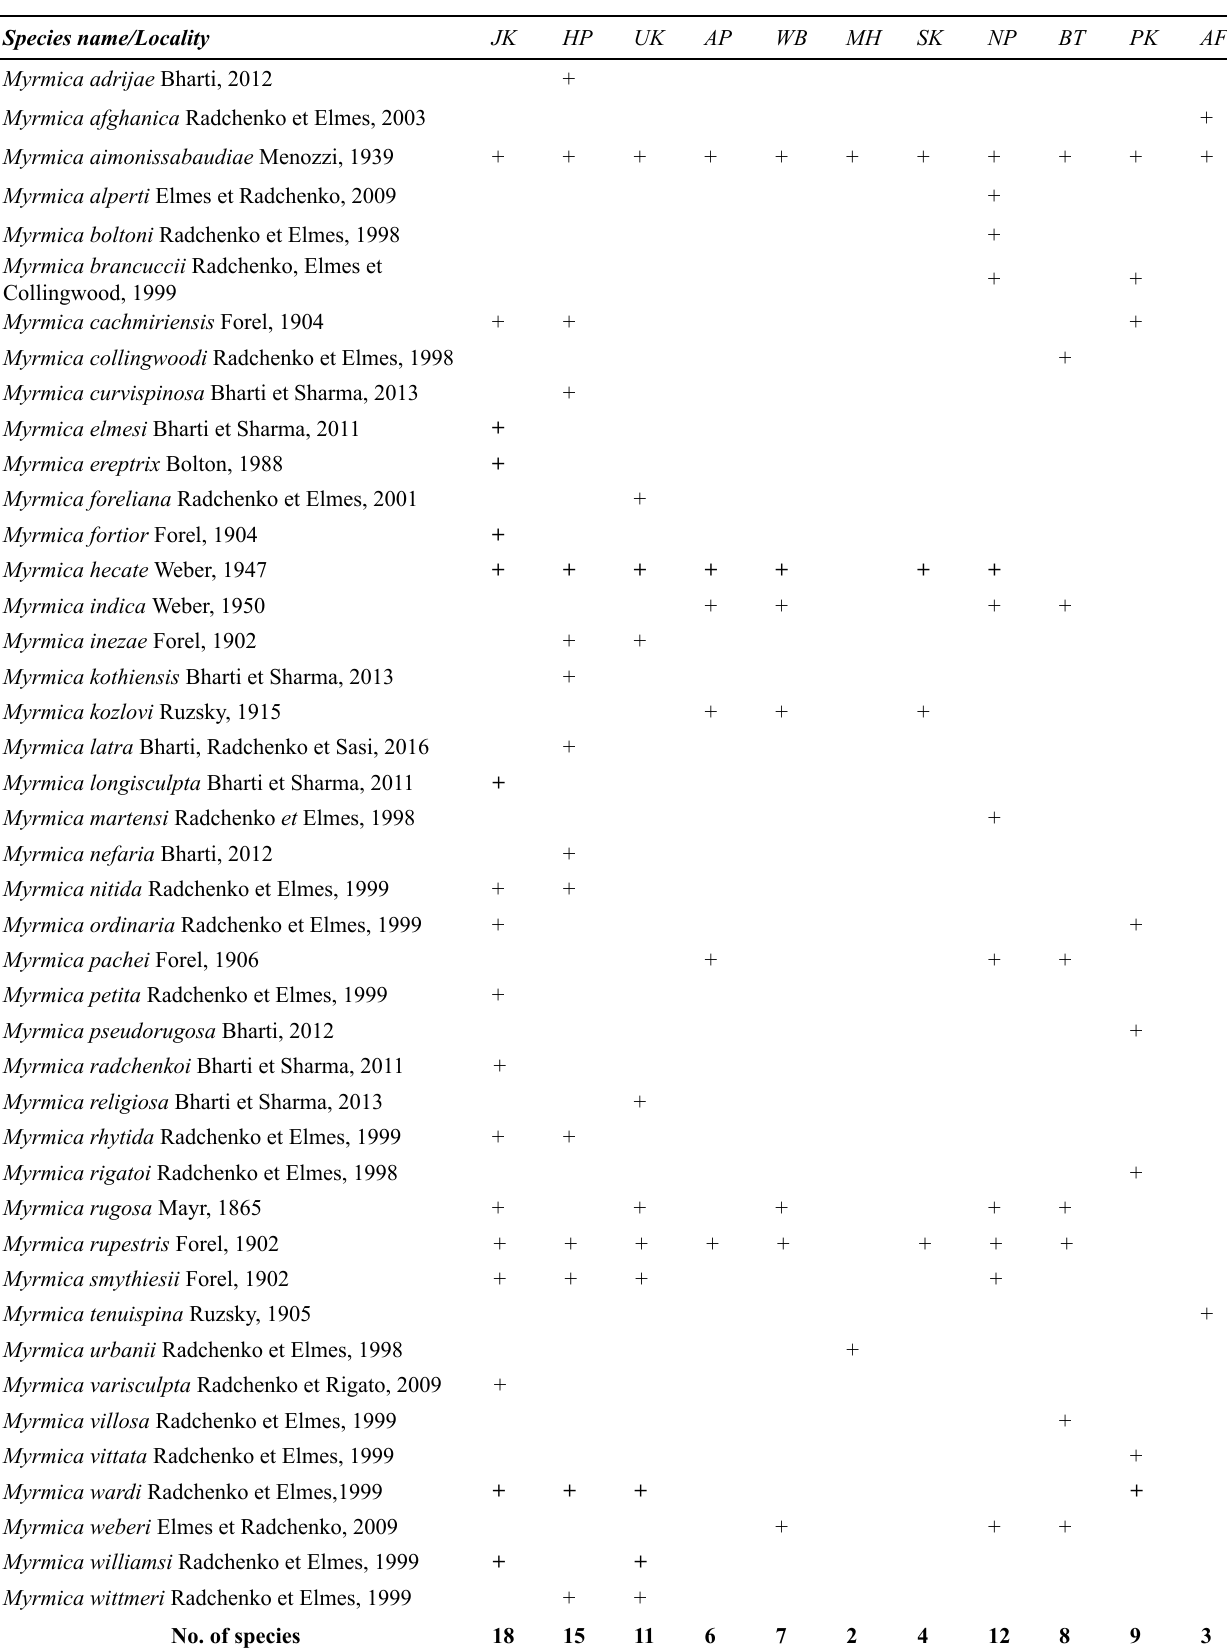
Table 2 . Known species diversity of genus Myrmica in each